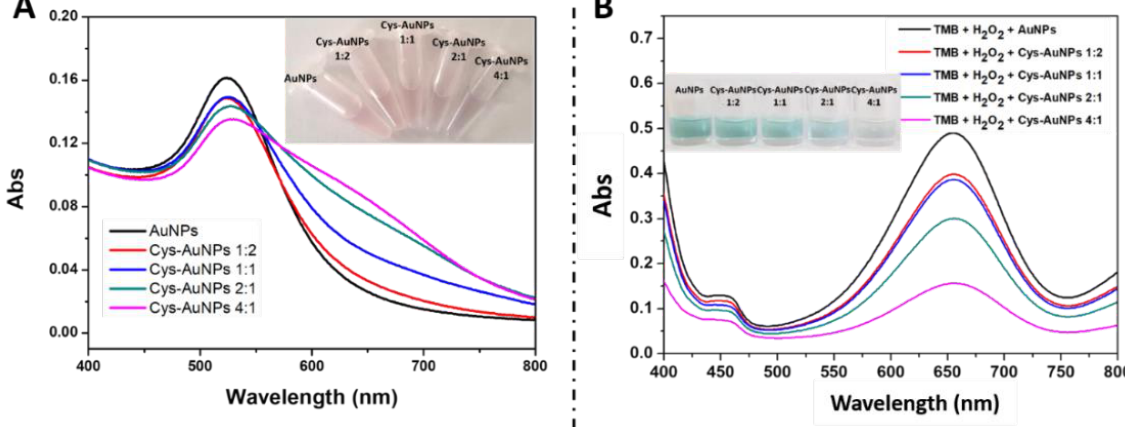
Figure 1. ( A ) Ultraviolet-Visible (UV-Vis) spectra for prepared cysteamine-capped gold nanoparticles (Cys/AuNPs) at various volume ratios of AuNPs and cysteamine. ( B ) UV-Vis spectra of 3, 3′ ,5, 5′ tetramethylbenzidine and hydrogen peroxide (TMB-H 2 O 2 ) solution catalyzed by Cys/AuNPs com- posites at various volume ratios of AuNPs and cysteamine.